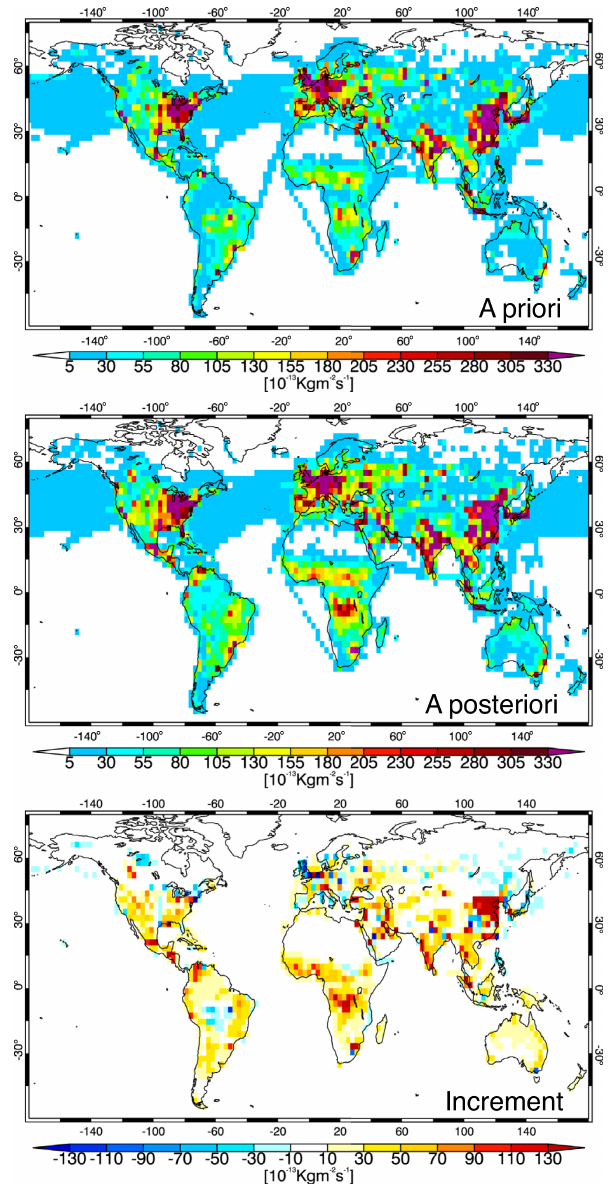
Figure 5. Global distributions of surface NO x emissions (in 10 − 13 kgm − 2 s − 1 ) averaged over 2005–2014. The a priori emis- sions (top panel), a posteriori emissions from the data assimila- tion run (middle panel), and analysis increment (bottom panel) are shown.